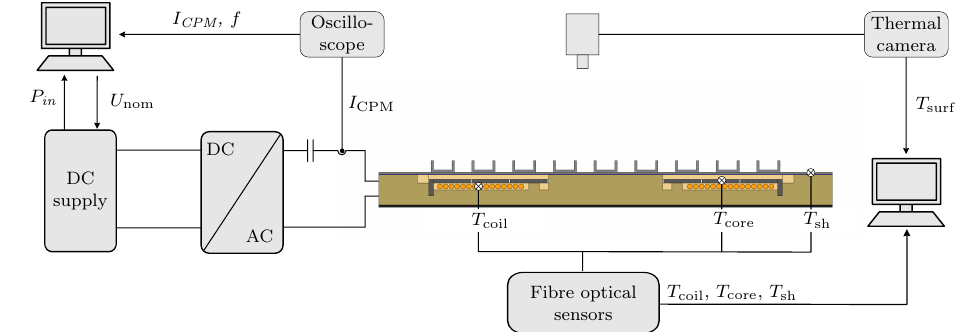
Figure 5. Experimental setup of module